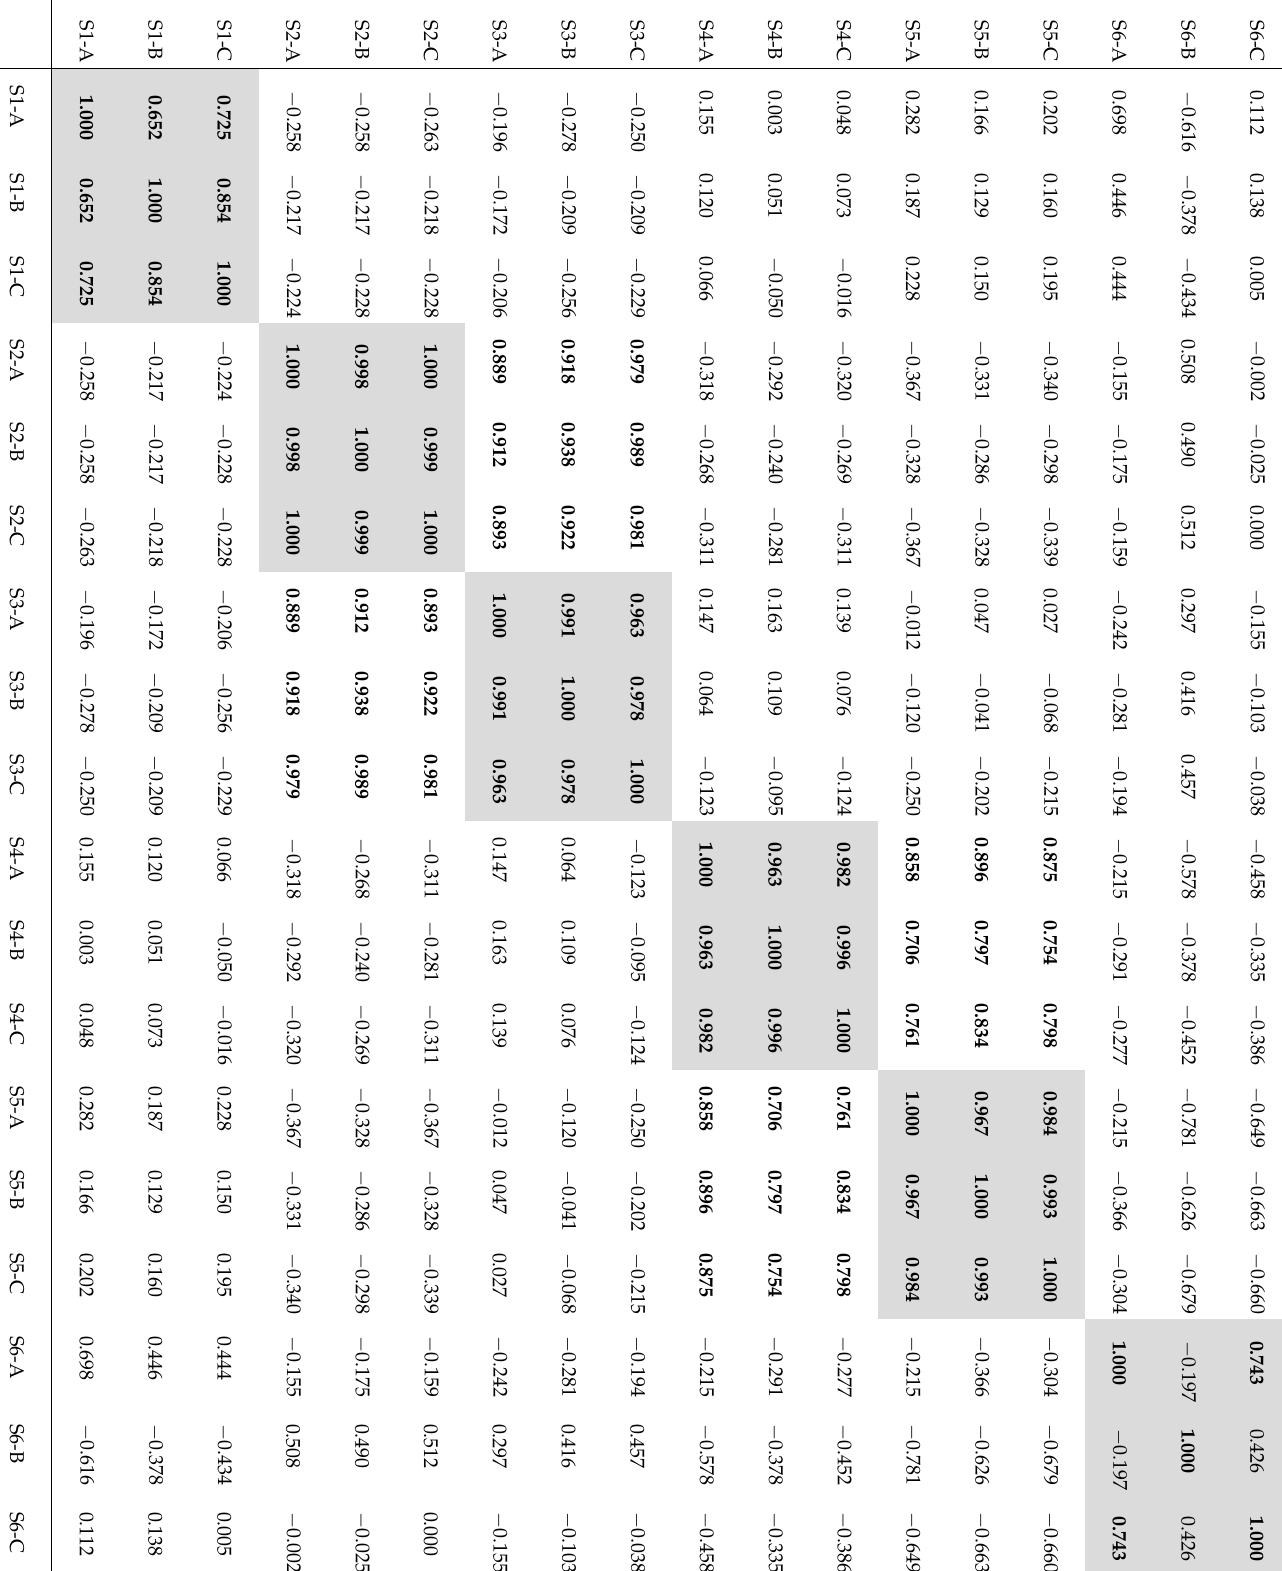
Table 2. Correlation coefficients between data collected by the reference system (A) and the novel sys- tem receivers (B and C). Boxes filled with grey colour are the correlation coefficients between data col- lected at the exact sampling location. The coefficients highlighted in bold suggest a high